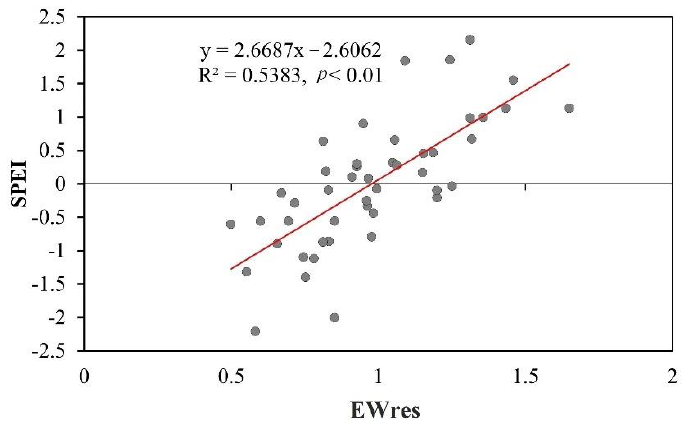
Figure 5. Scatterplot of the linear regression model showing the variability of the earlywood residual chronology (EWres) with the six-month cumulative SPEI from February to May 1974–2019 (46